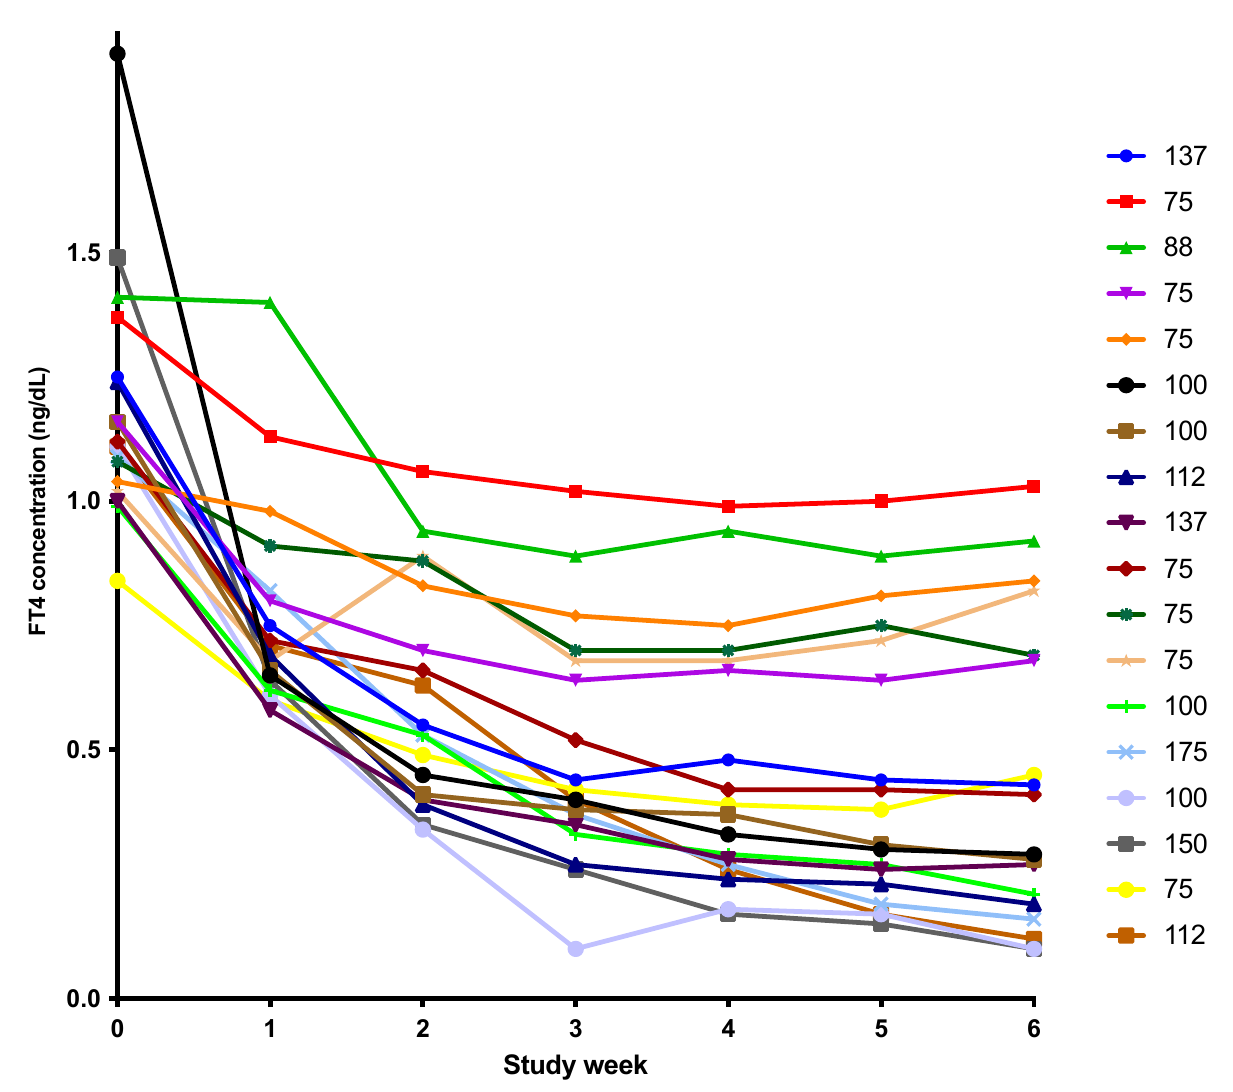
Figure 1. Weekly drop in FT4 concentration with LT3 therapy in 18 patients with hypothyroidism. (FT4: free thyroxine, LT3: liothyronine. The legend on the right of the figure indicates the LT4 dose being taken by each patient prior to the start of the study.)